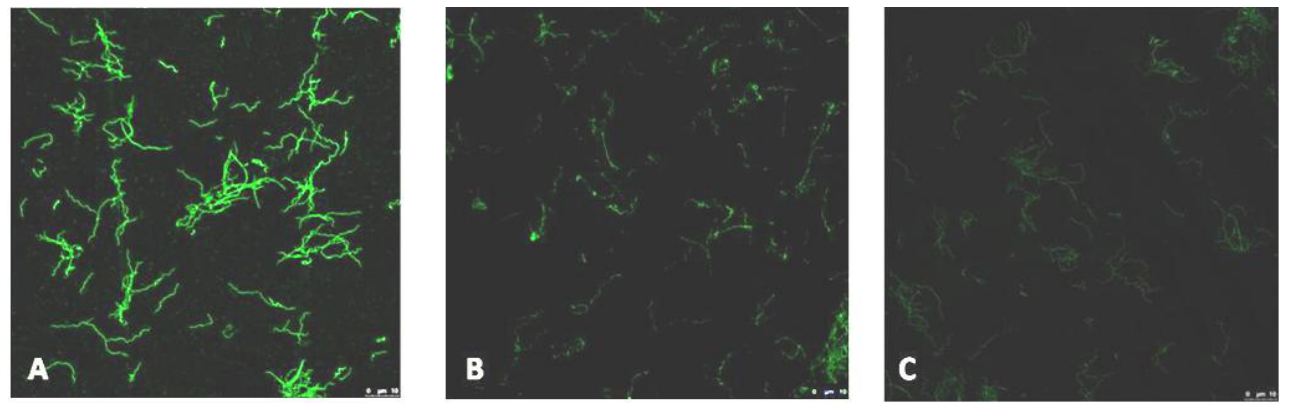
Figure 1. Typical pattern of B. burgdorferi IFA. ( A ) Positive sera; ( B ) Uncertain sera; ( C ) Negative